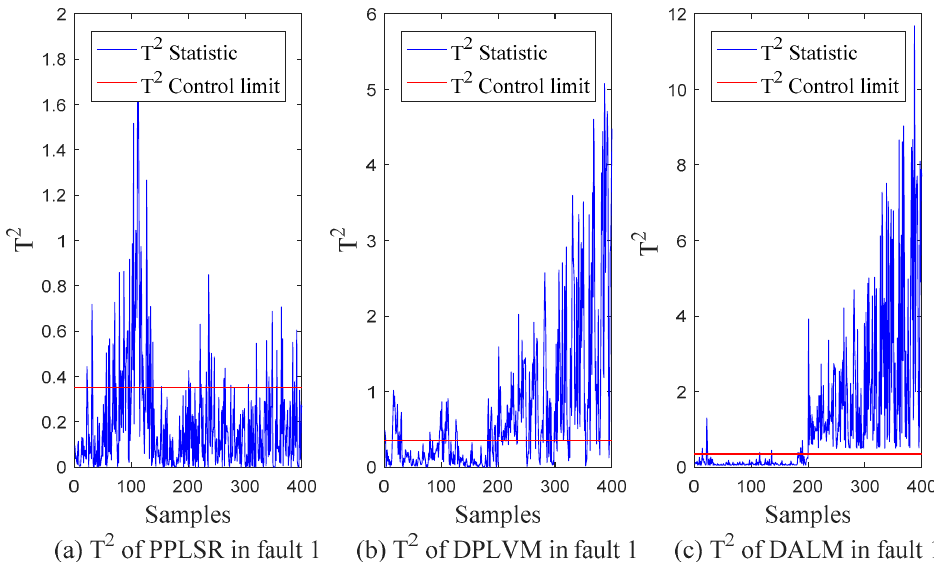
Figure 6. Monitoring results of fault 1. ( a ) T 2 of PPLSR in fault 1; ( b ) T 2 of DPLVM in fault 1; ( c ) T 2 of DALM in fault 1.